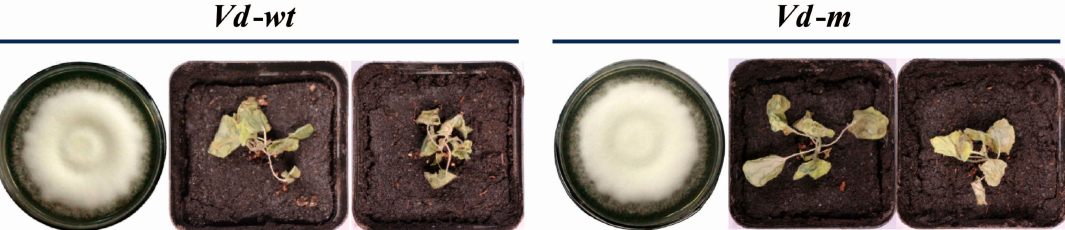
Figure 3. Fungal morphology on potato dextrose agar (PDA) plates and disease symptoms on N. benthamiana ten days after inoculation with strain Vd-m or Vd-wt